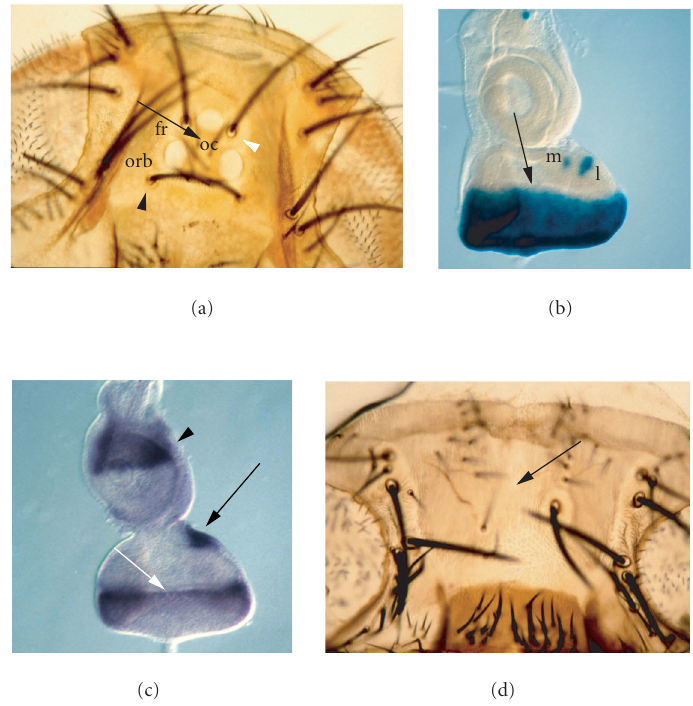
Figure 3. Hh is required for adult head development. (a) and (d) Dorsal views of the head capsules of flies of the indicated genotypes. (c) and (b) Eye-antennal discs. (a) Head of a wild-type fly with the interocellar cuticle (arrow). The normal appearance of the ocellar region (oc), frons (fr), and orbital region (orb) can be seen. The two ocellar bristles, which lie near the medial ocellus, are evident (white arrowhead indicates one of them). The two postvertical bristles (black arrowhead) lie near the lateral ocelli. The interocellar cuticle also contains 6–8 microchaetes (the interocellar bristles). (b) Third instar eye-antennal discs of L1 line were dissected and stained with X-gal to detect β -galactosidase activity. Staining is present posterior to the morphogenetic furrow (arrow) and in the precursors of the median (m) and lateral (l) ocelli. (c) Wild-type eye-antennal disc hybridized with a digoxigenin-labeled hh probe. In situ hybridization reveals that, in addition to being expressed in the dorsal head primordium (black arrow), hh is expressed posterior to the morphogenetic furrow (white arrow). Parts of the antennal anlagen express hh as well (arrowhead). (d) Head of an hh ts 2 / hh ts 2 fly raised at the restrictive temperature (30 ◦ C) during the third larval instar. Loss of hh function eliminates the entire medial domain of the dorsal head, including the ocelli, interocellar cuticle, and the ocellar, postvertical, and interocellar bristles. This region is replaced by ridged frons cuticle (arrow). Heads are at the same magnification. Discs are at the same